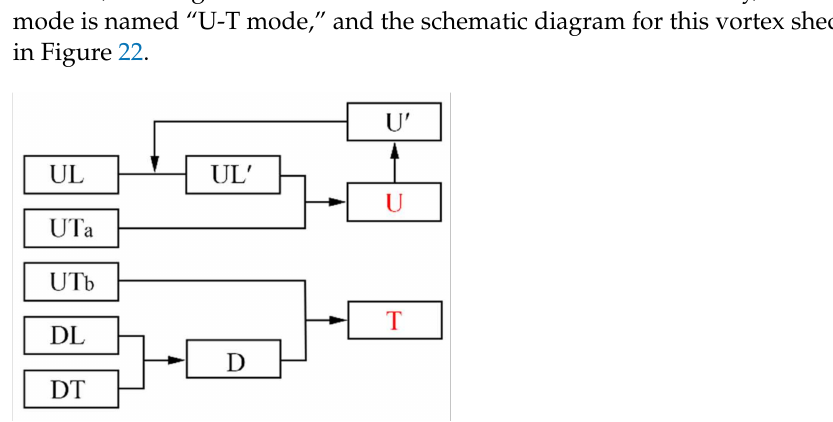
Figure 22. The schematic diagram of vortex evolution in U-T